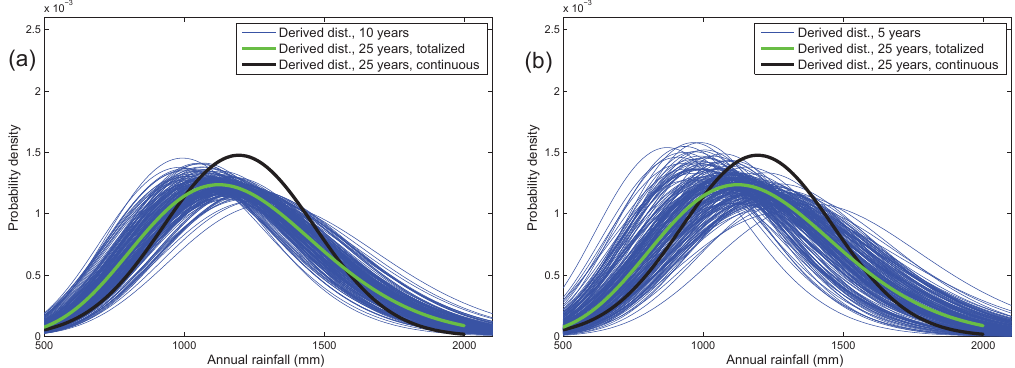
Figure 12. Estimated pdfs for 10-year (a) and 5-year (b) subsamples using a 24h totalized record in Concepción.